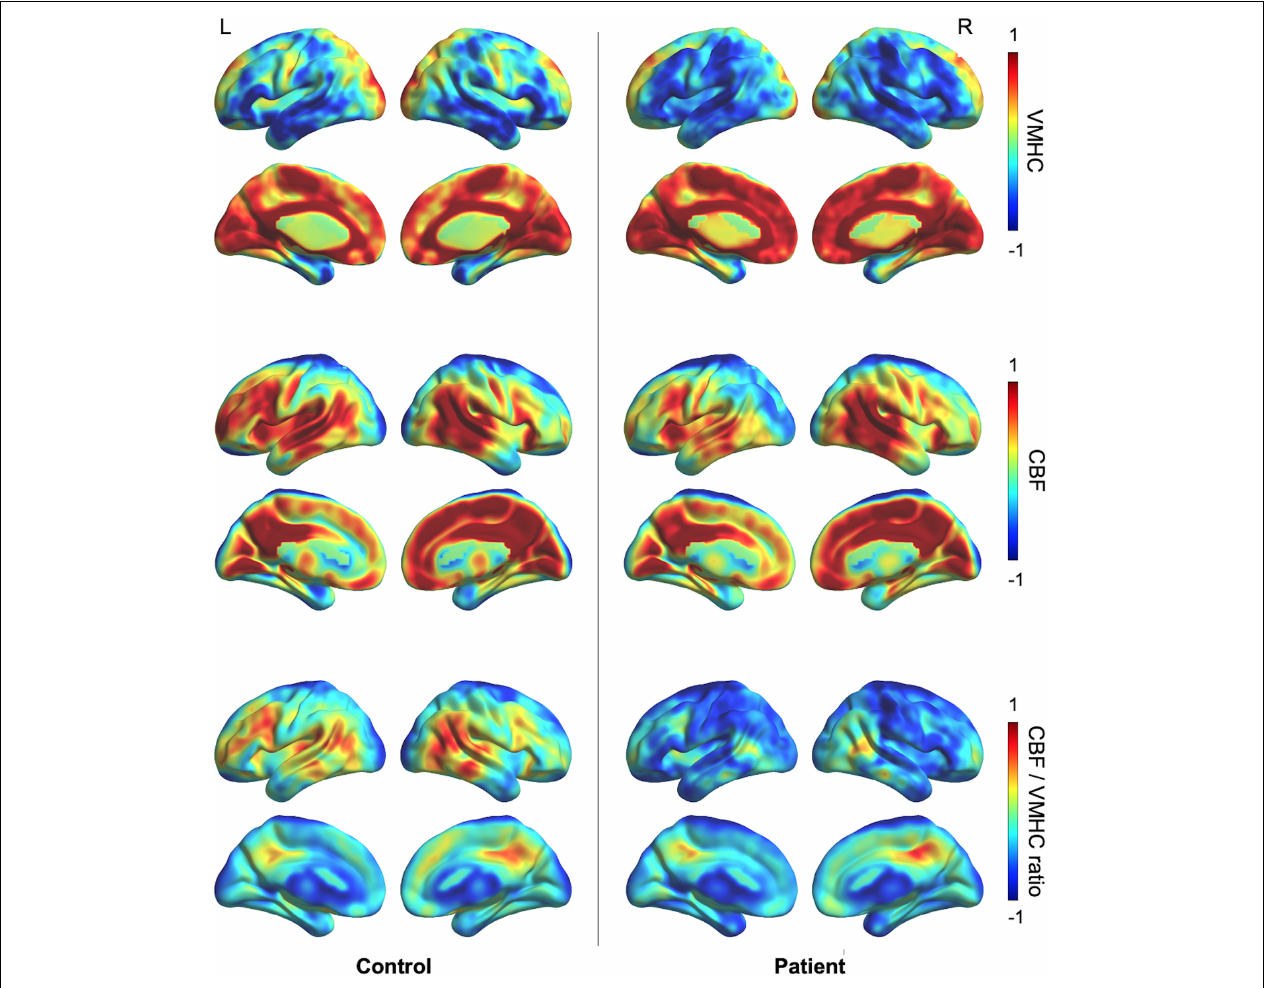
FIGURE 2 | Group-specific averaged maps showing the spatial distribution of VMHC, CBF, and the CBF/VMHC ratio. The VMHC, CBF, and CBF/VMHC ratio maps were normalized to z -scores and averaged across participants within groups. CBF, cerebral blood flow; VMHC, voxel-mirrored homotopic